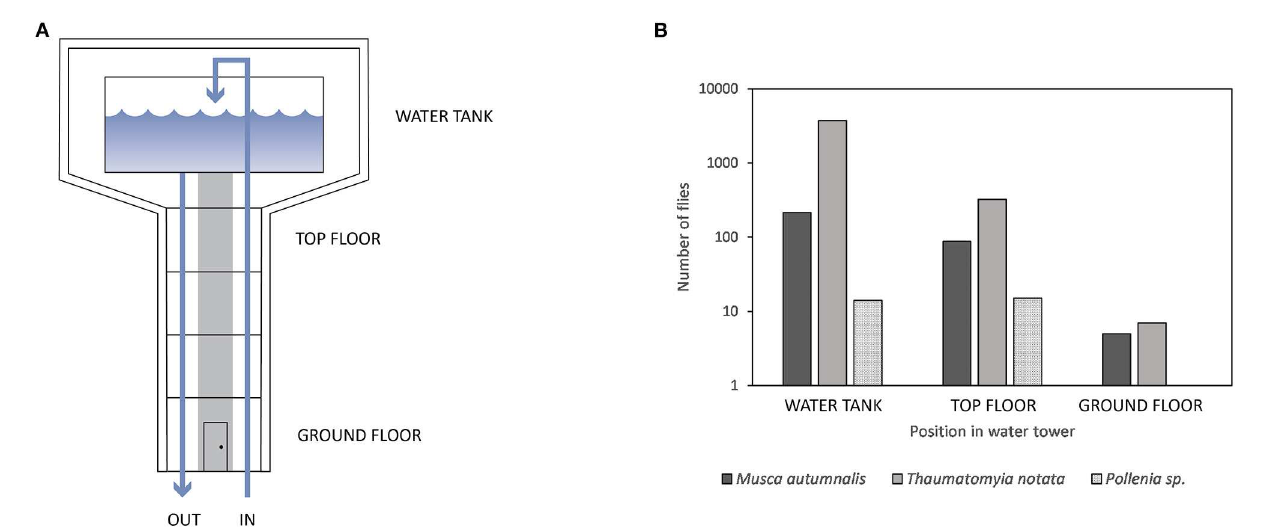
FIGURE2 (A) Schematic representation of a water tower with the different levels where monitoring took place. (B) The number of flies caught on sticky traps on the different levels in water towers ( n = 10). Monitoring was performed weekly from September 2019 until the end of April 2020. Most flies were caught at the water tank level. No Pollenia species were caught on the ground floor.